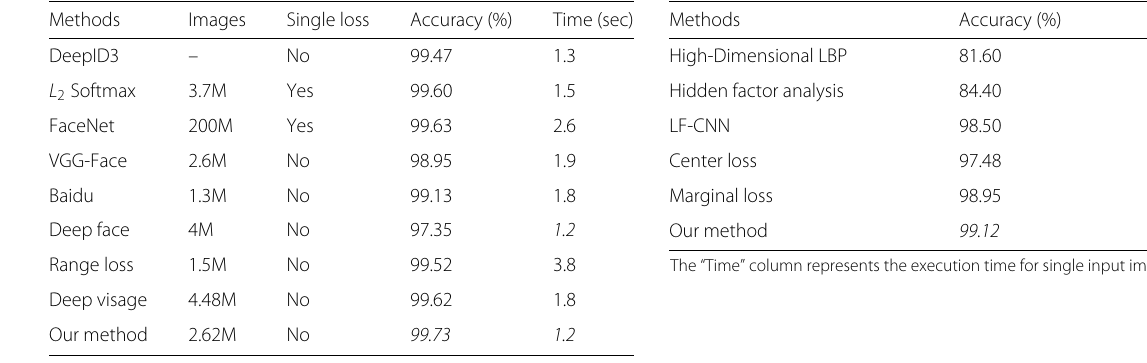
Table 2 Face verification performances on LFW